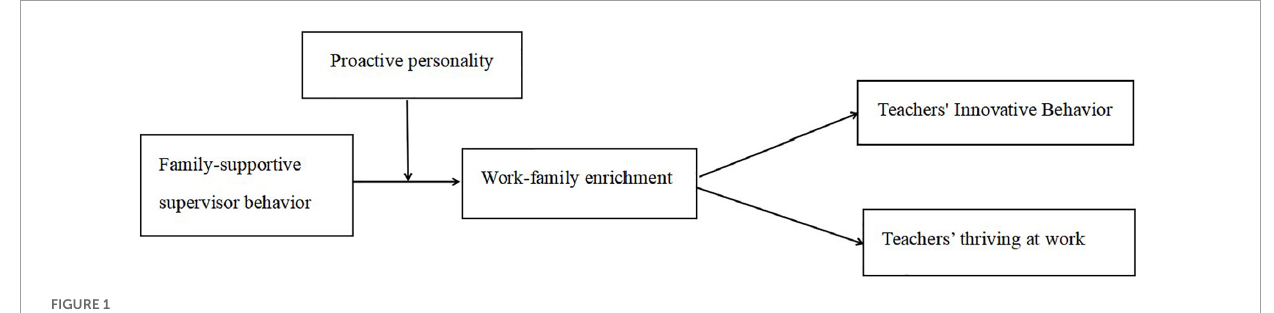
FIGURE1 Theoretical